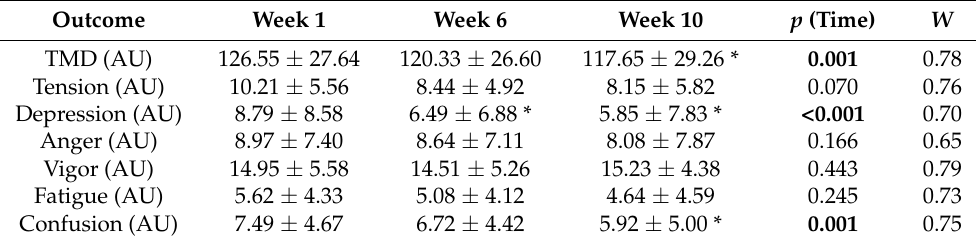
Table 2. Summary of the mood state scores of the different time points. Outcome